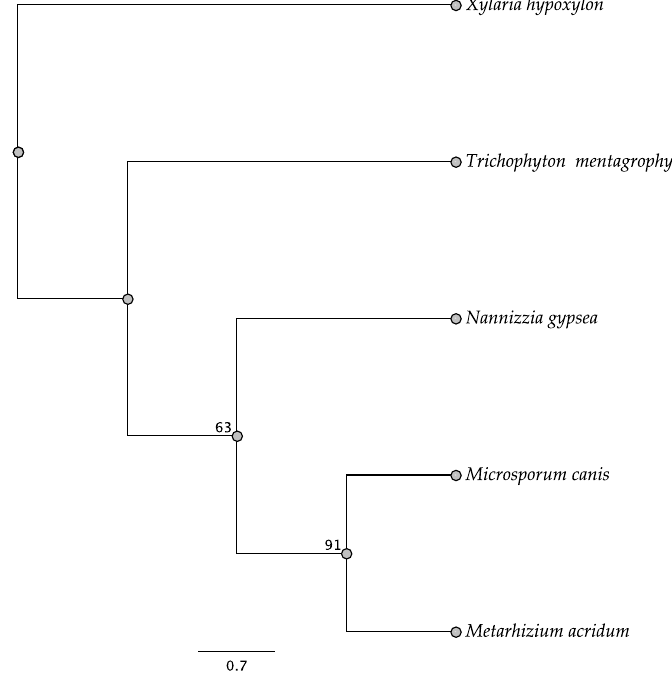
Figure 13. Maximum parsimony DNA tree resulting from the analysis of the swnN – swnH1 intergenic region sequence data. Bootstrap confidence values from 1000 bootstrap replicates are presented at each corresponding node. Fungal orders are indicated next to each organism/clade.